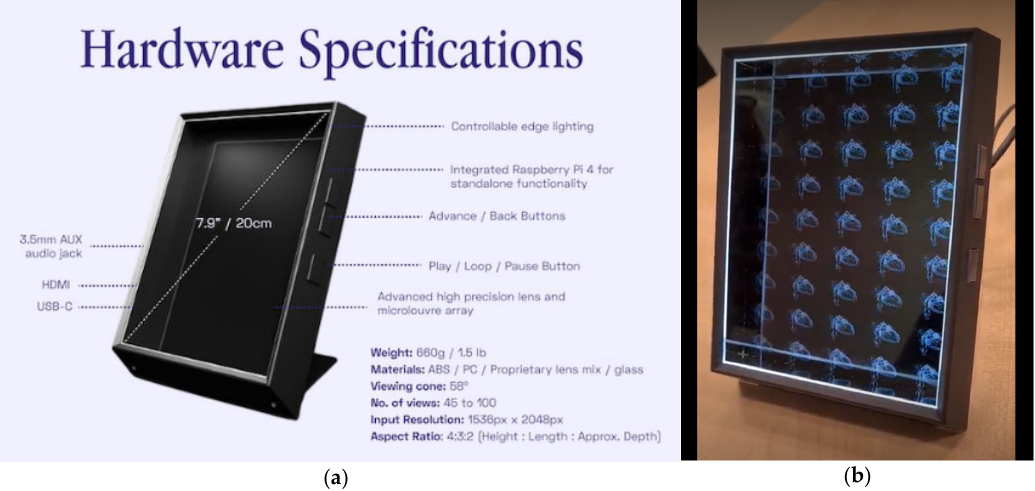
Figure 2. ( a ) The hardware specification of TLG portrait [25]. ( b ) An image of TLG portrait in quilt mode showing an X ‐ ray textured model